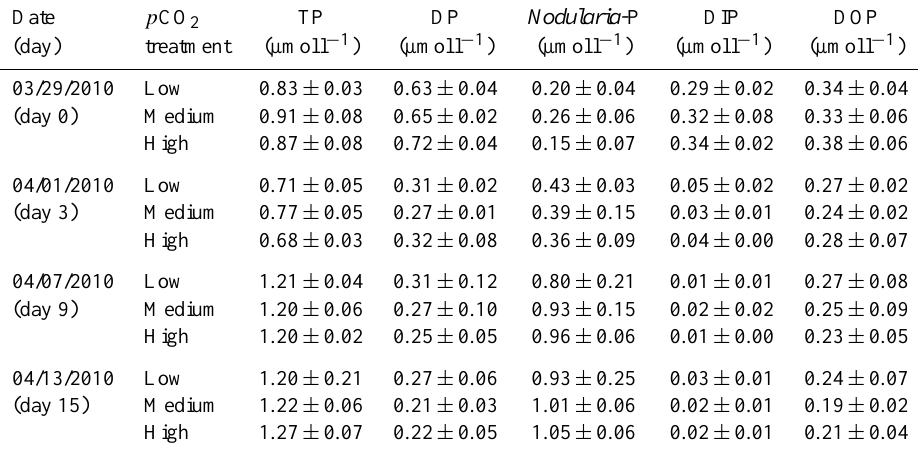
Table 1. The phosphorus pool fractions at the four sampling times. Values are means and standard deviations of three replicates except for DIP where one replicate bottle was excluded (low-II at day 9). Values of DIP and DOP are according to Wannicke et al.